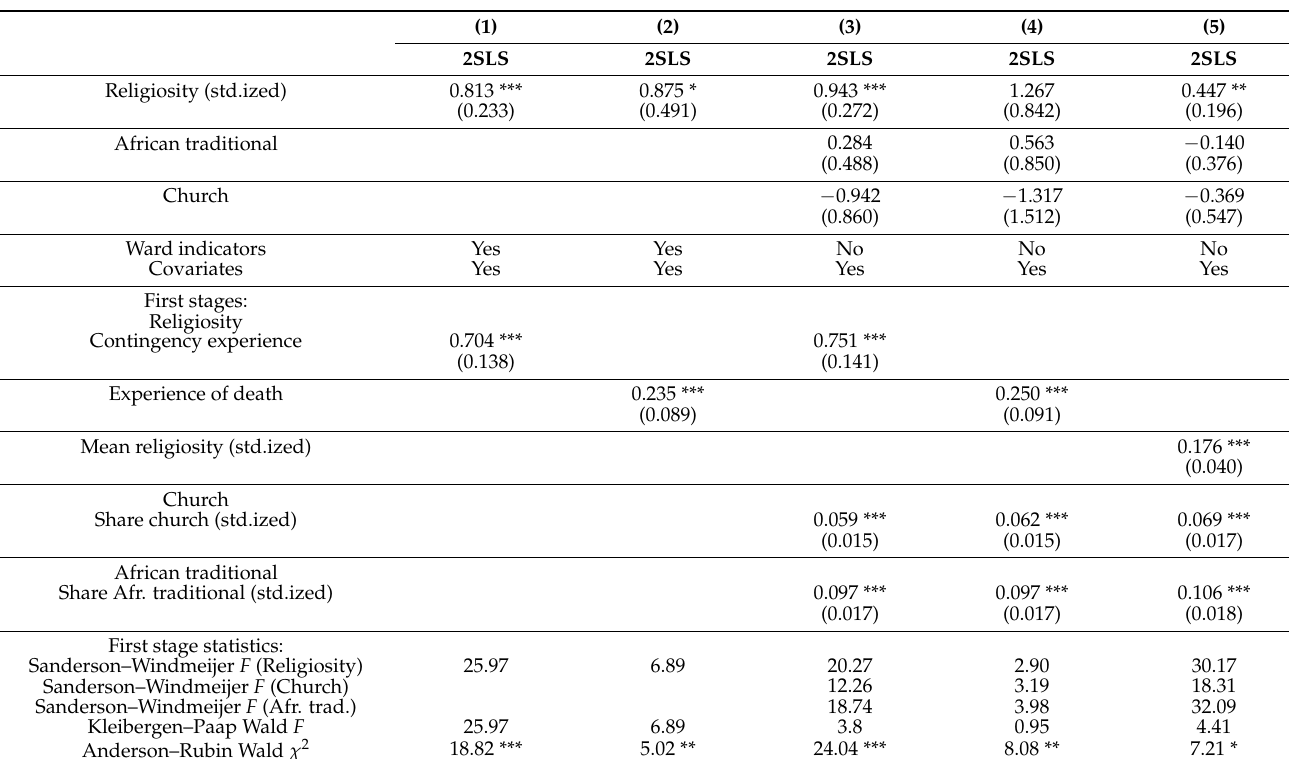
Table A2. Results two-stage least squares estimation.